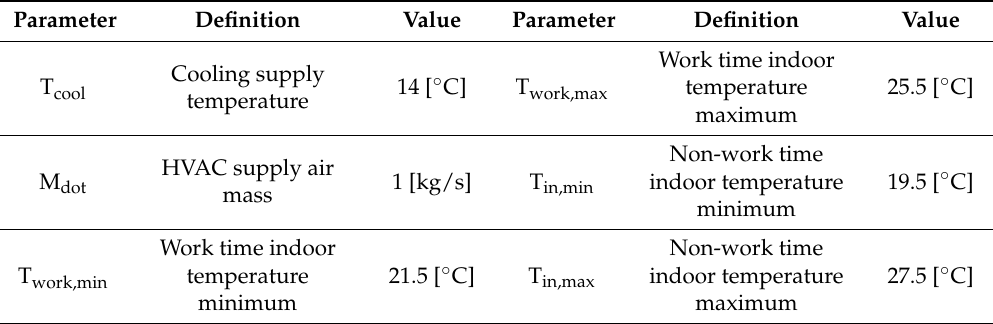
Table 3. Configuration data of the HVAC system.